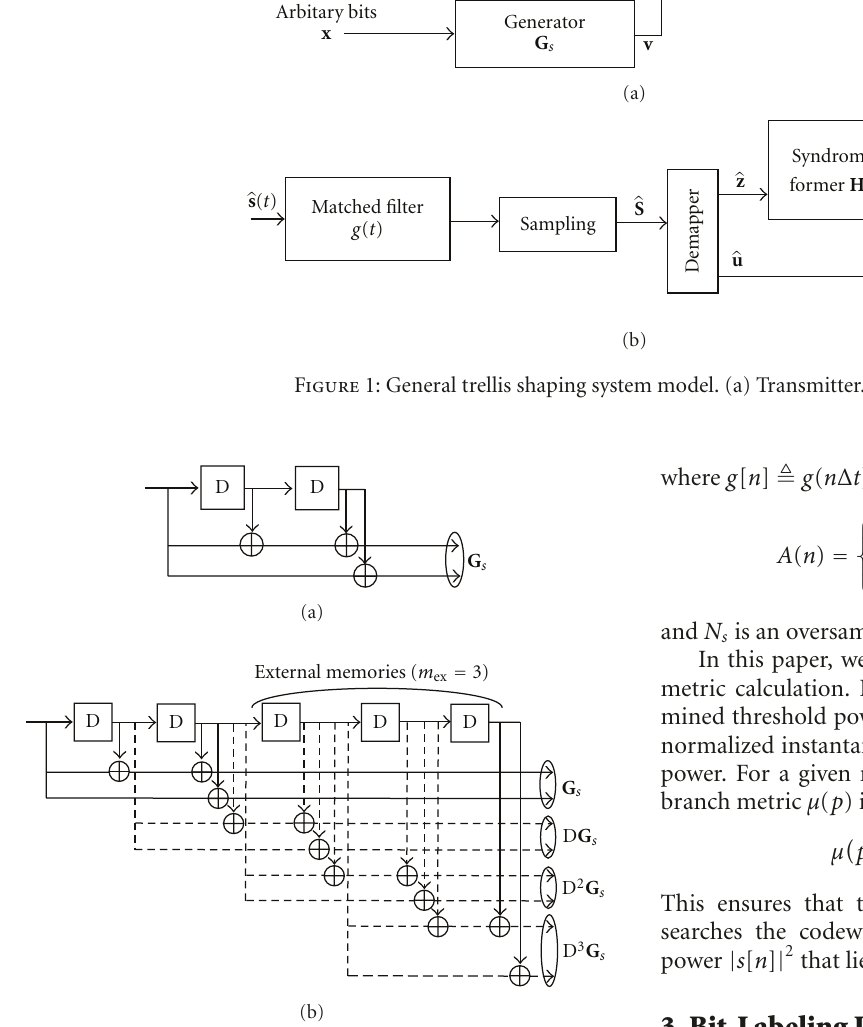
Figure 2: Construction example of code generator. (a) Code generator ( ν = 2). (b) Code generator with external memories ( m ex =